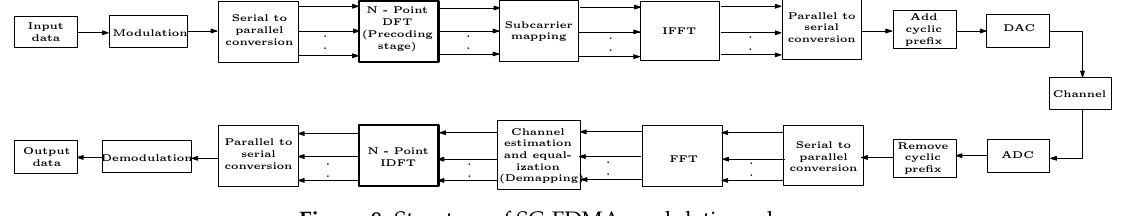
Figure 8. Structure of SC-FDMA modulation